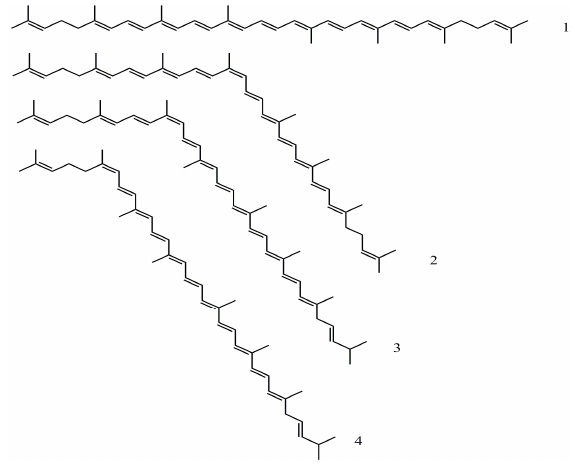
Figure 1. Geometrical forms of lycopene detected in human plasma exposed to cigarette smoke: ( 1 ) (all- E )-lycopene; ( 2 ) (13 Z )-lycopene; ( 3 ) (9 Z )-lycopene; ( 4 ) (5 Z ) lycopene .